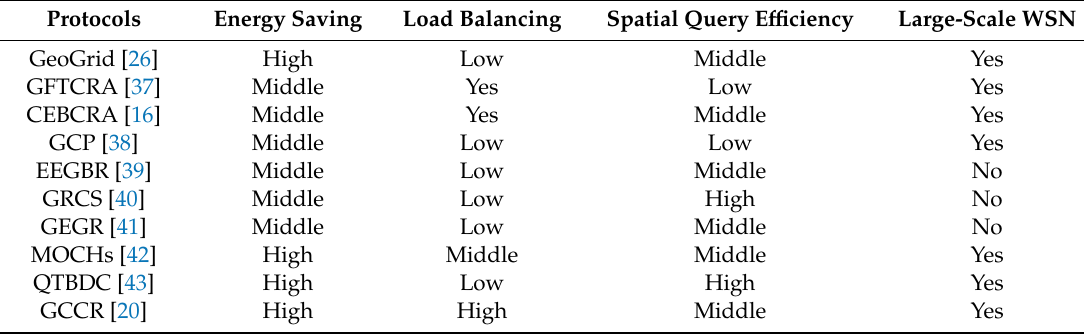
Table 1. Comparison of various clustering GR (Geographic routing)